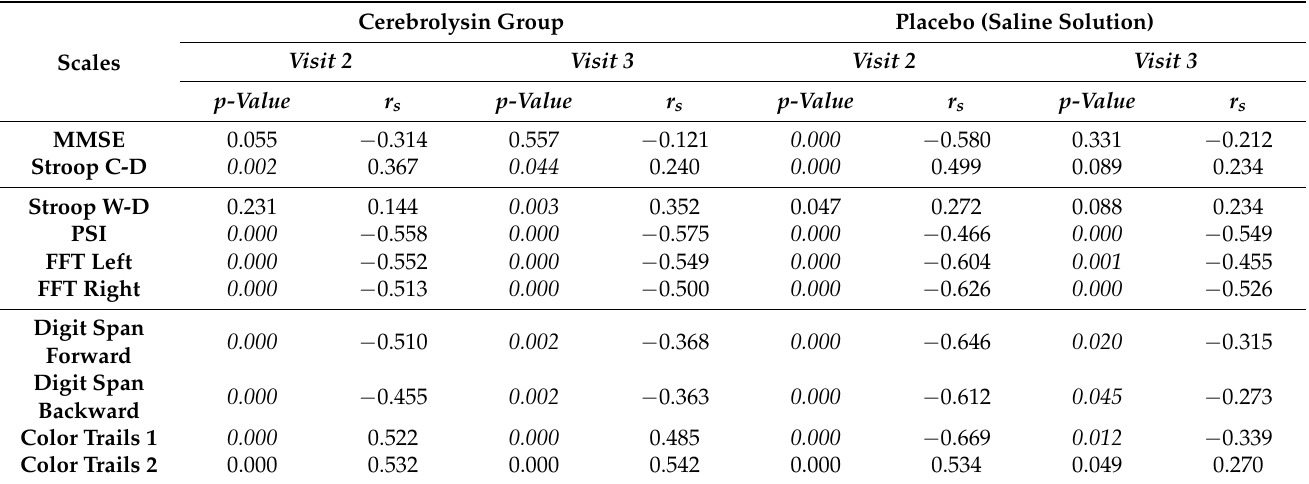
Table 7. Correlations with